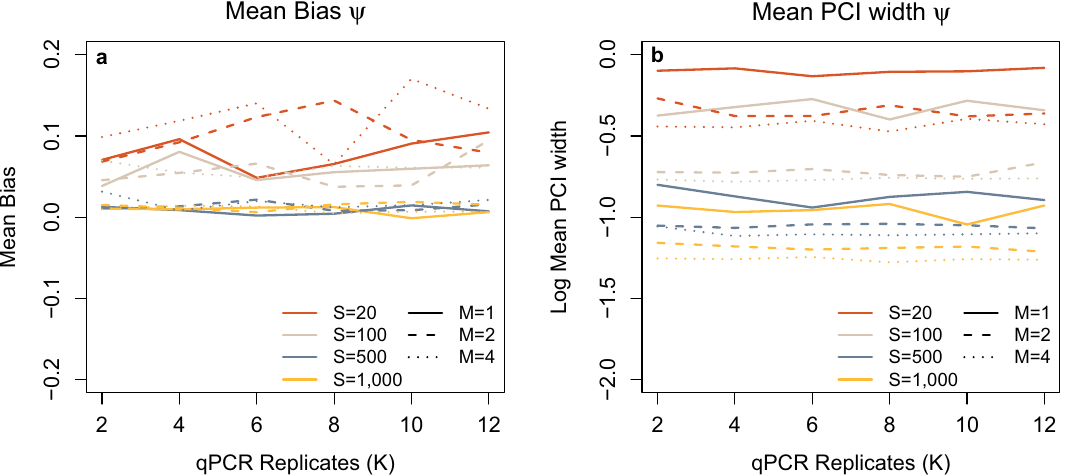
Figure 2. ( a ) Mean bias in occupancy (ψ) estimate with varying numbers of sites (S), samples collected (M) and qPCR replication (K). ( b ) Mean 95% PCI width for occupancy (ψ) plotted on a logarithmic scale, with varying numbers of sites (S), samples collected (M) and qPCR replication